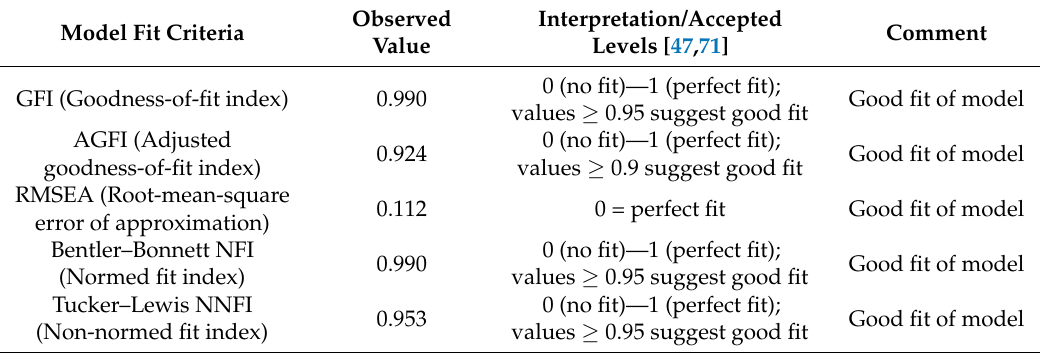
Table 8. Goodness-of-fit statistics for the fitted SEM model.